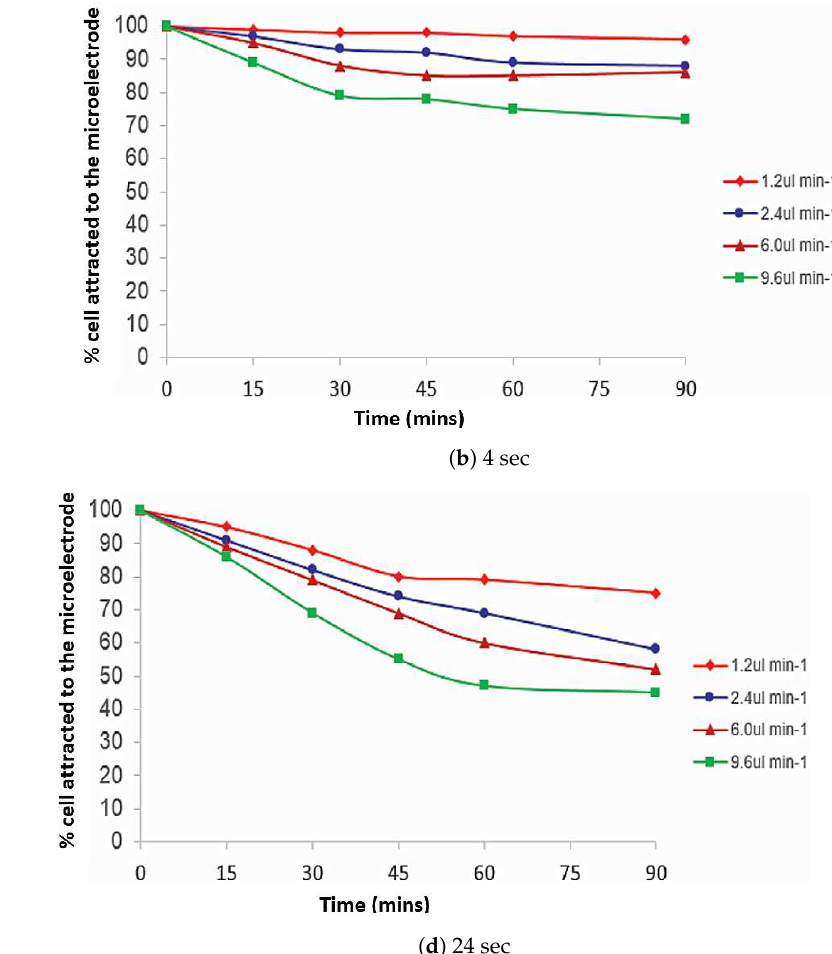
Figure 8. Percentage of S. cerevisiae cells attracted to the microelectrode as a function of time, comparing the pulsing time applied with the variation of flow